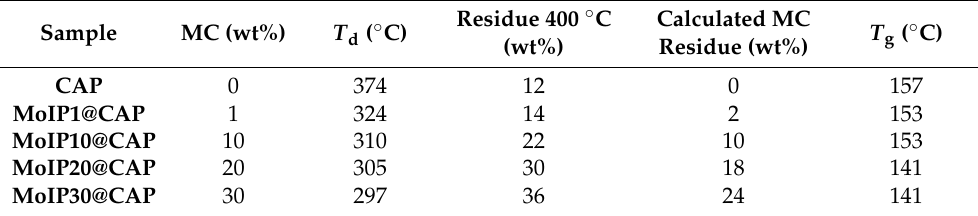
Table 1. Composition and thermal behavior of doped CAP films: T d : final decomposition temperature, T g : glass transition temperature determined from the second cooling cycle.